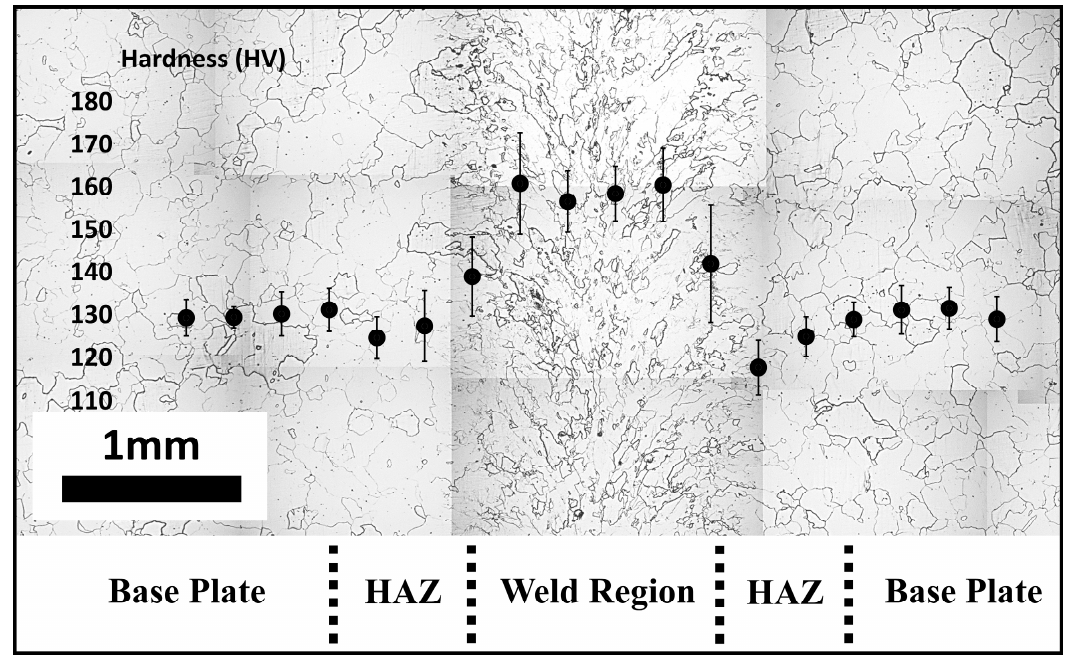
Figure 1. Optical micrograph of the weld region, heat-affected zone, and base plate of sample A. The profile of Vickers hardness is displayed along the corresponding areas.